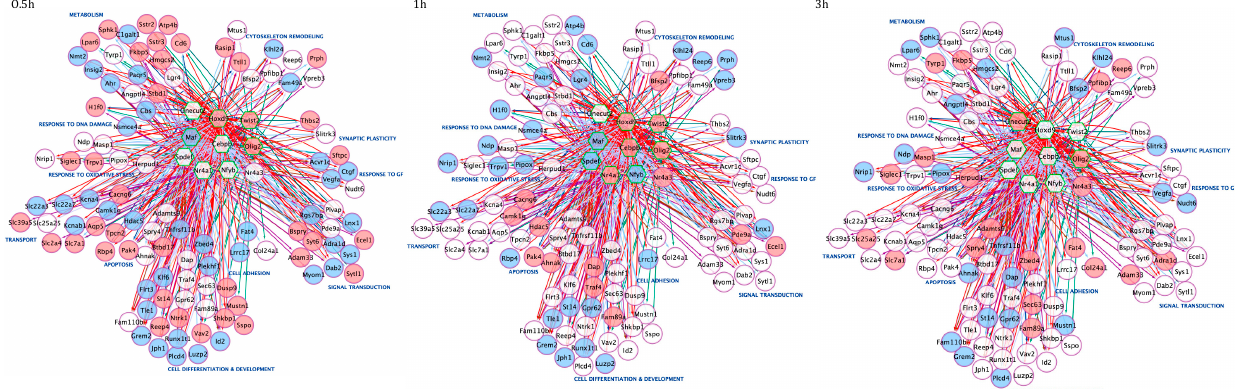
Figure 7. Time-course TF-gene regulatory networks revealed a common early and transient peak of transcription of upstream regulators modulating the expression of core set genes. Networks were visualized by Cytoscape . For each time-point, the node color is consistent with the logFC of each gene: genes in blue are downregulated by GF treatment, whereas the genes in red are upregulated. Targets are represented as circle nodes with purple borders and TF as green hexagon nodes. Regulons for each TF are represented by different edge colors. Target genes are grouped according to their biological functions.